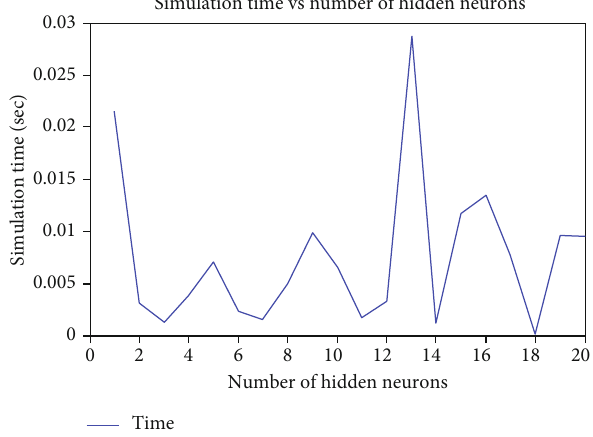
Figure 10: Three input MLPNN-based forecasting model simulation times vs. the number of hidden